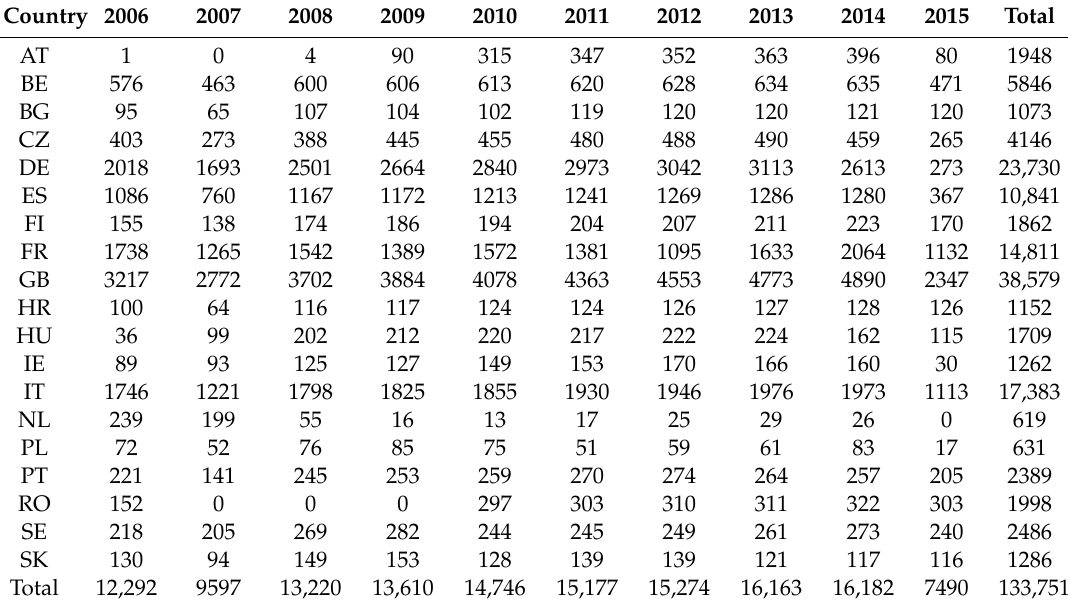
Figure 3. Plot of scoring bankruptcy risk by year. Source . Performed by the authors based on data provided by Amadeus database.